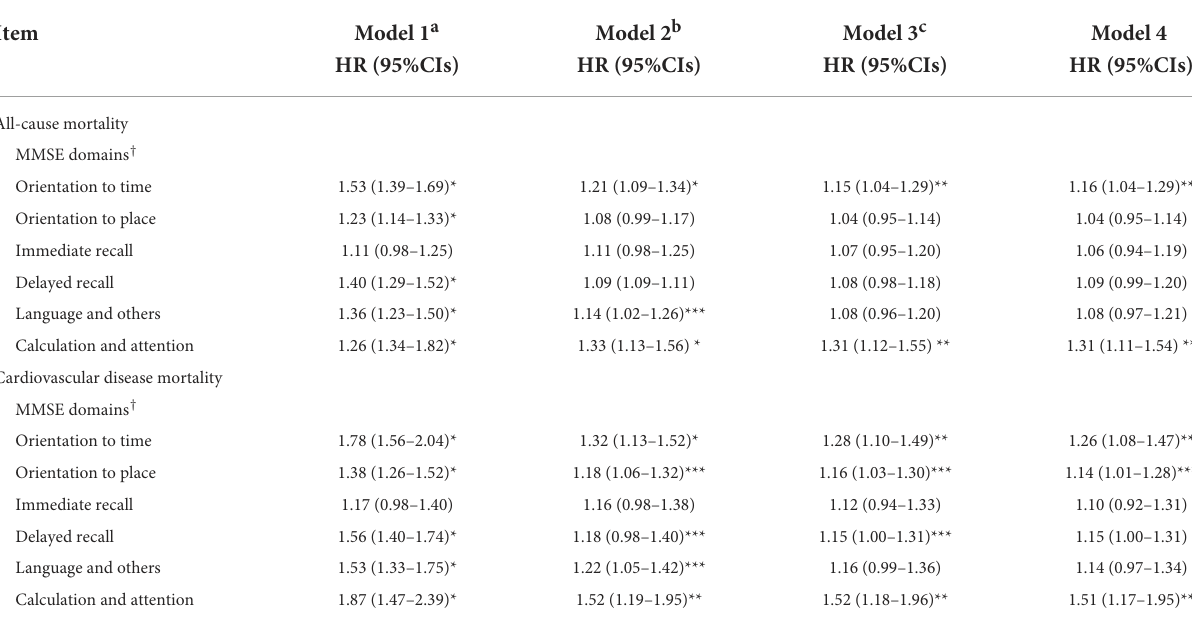
TABLE 3 Hazard ratio of all-cause and CVD mortality among MMSE